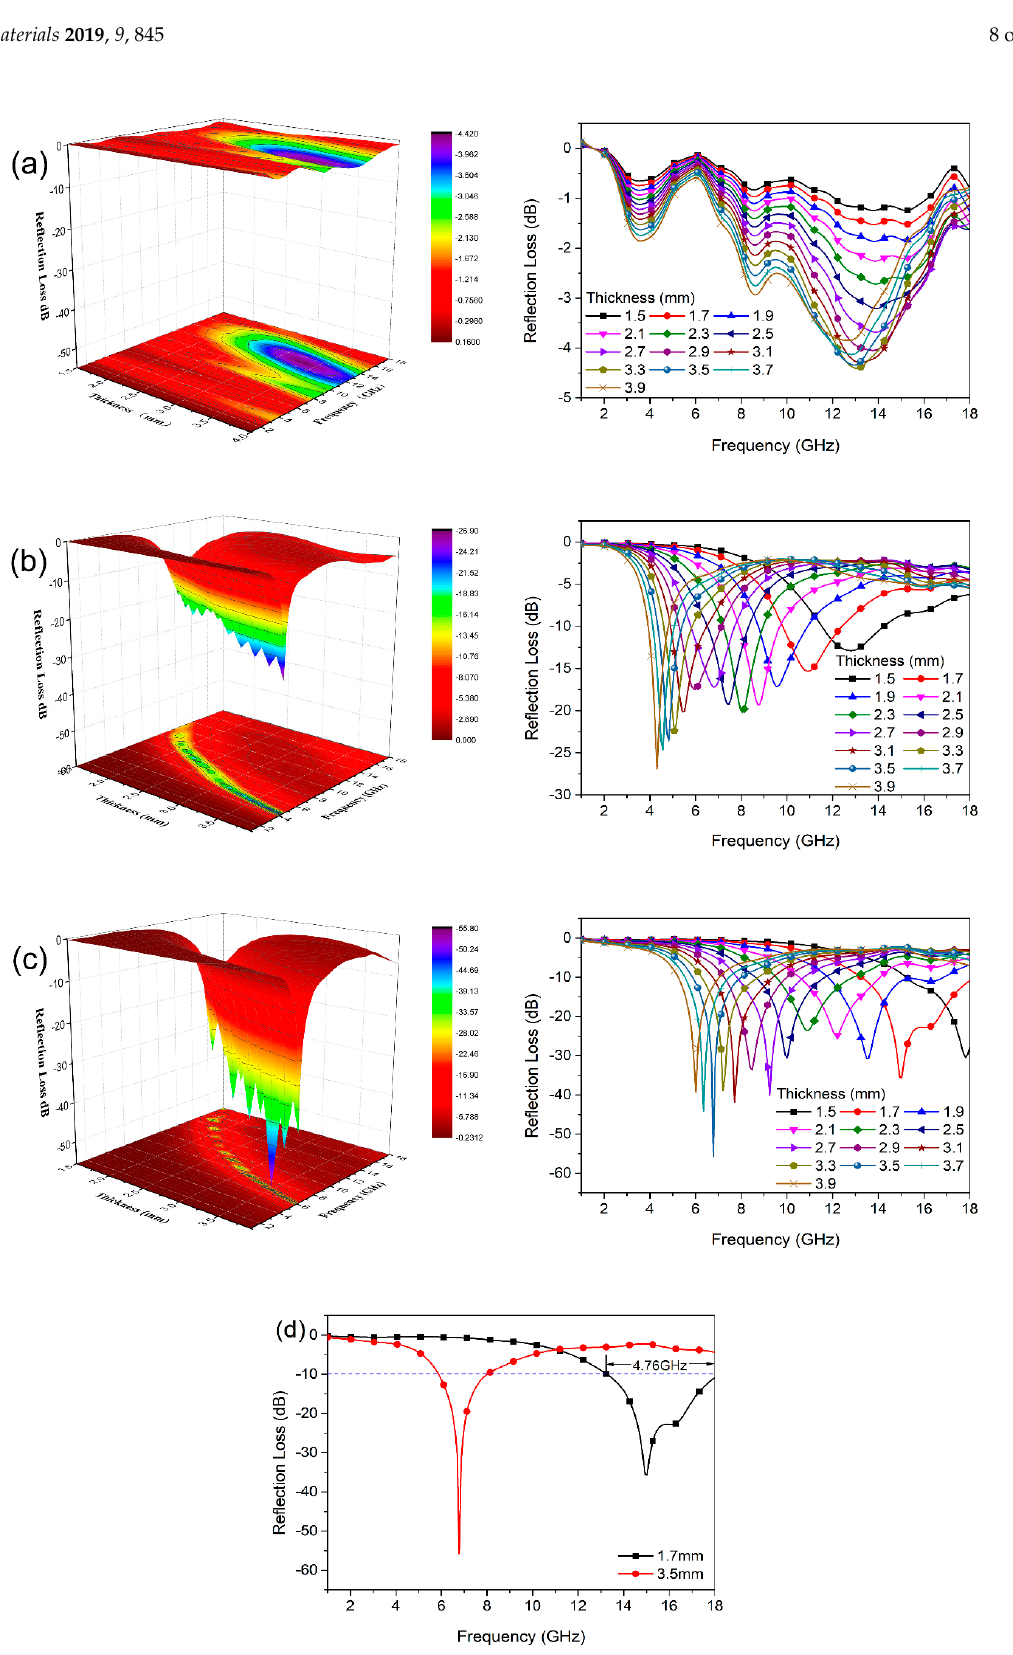
Figure 5. Reflection loss (RL) curves and 3D representation of ( a ) Fe 3 O 4 NPs, ( b ) RGO, and ( c ) RGO / Fe 3 O 4 with di ff erent thicknesses. ( d ) The RGO / Fe 3 O 4 sample achieves an e ff ective absorption bandwidth of 4.76 GHz at a thickness of 1.7 mm and reaches the maximum RL value of − 55.71 dB (6.78 GHz) at a thickness of 3.5